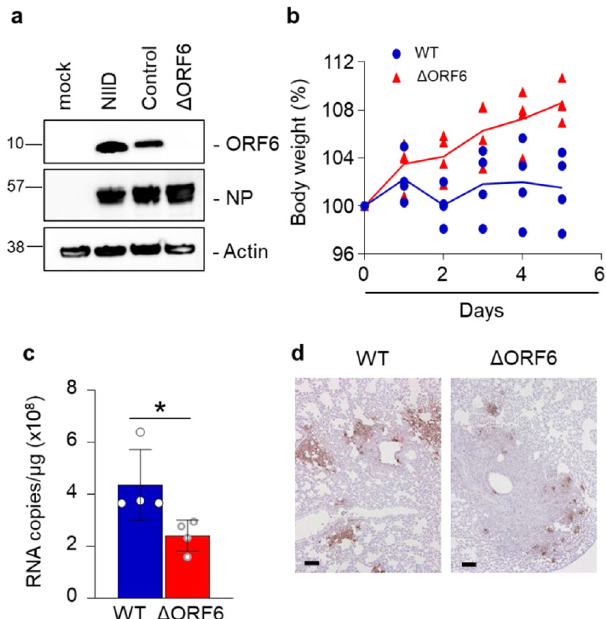
Fig. 7 Deletion of ORF6 in fl uences the pathogenicity in SARS-CoV-2 in vivo. a Detection of ORF6 in recombinant SARS-CoV-2 control (Nluc- 2A-ORF6) or Δ ORF6. VeroE6/TMPRSS2 cells were infected with SARS- CoV-2 WT (Nluc-2A-ORF6) or Δ ORF6 and the cell lysates were collected at 24 h post infection. Cell lysates were subjected to western blotting, and then detected the proteins using speci fi c antibodies for ORF6, NP, or